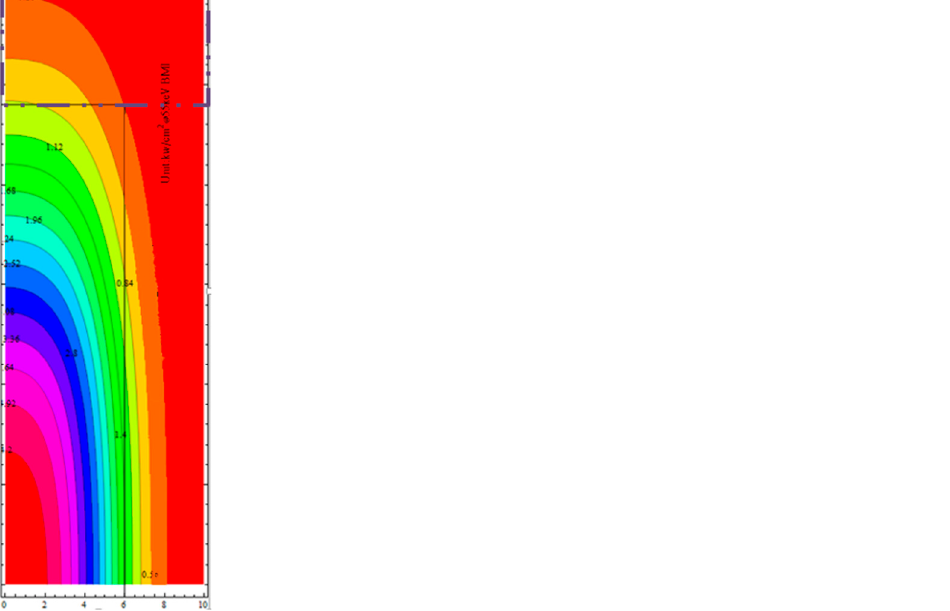
Figure 4. Heat flux deposition distribution of entrance collimators (1/4 part) on vertical direction.